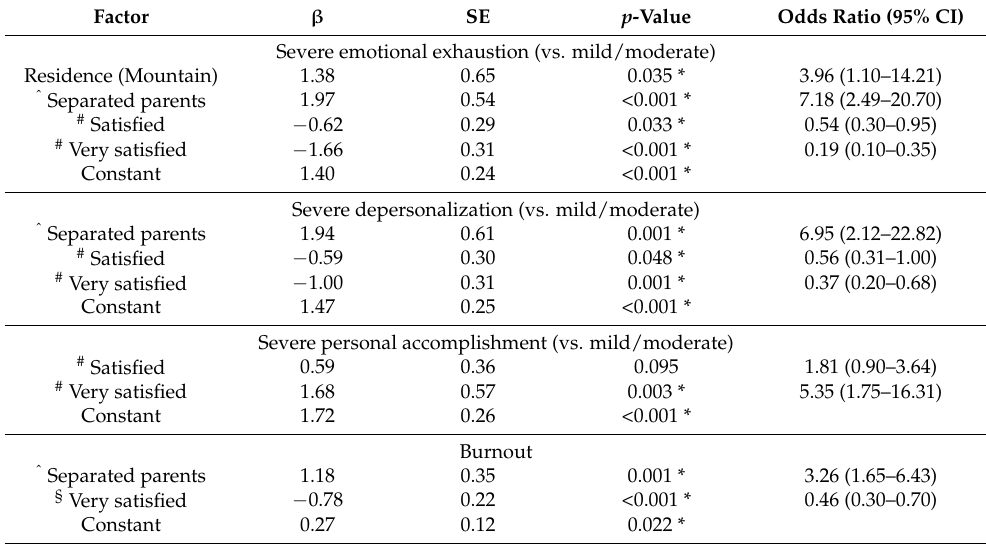
Table 3. Logistic regression for factors affecting burnout and its components.